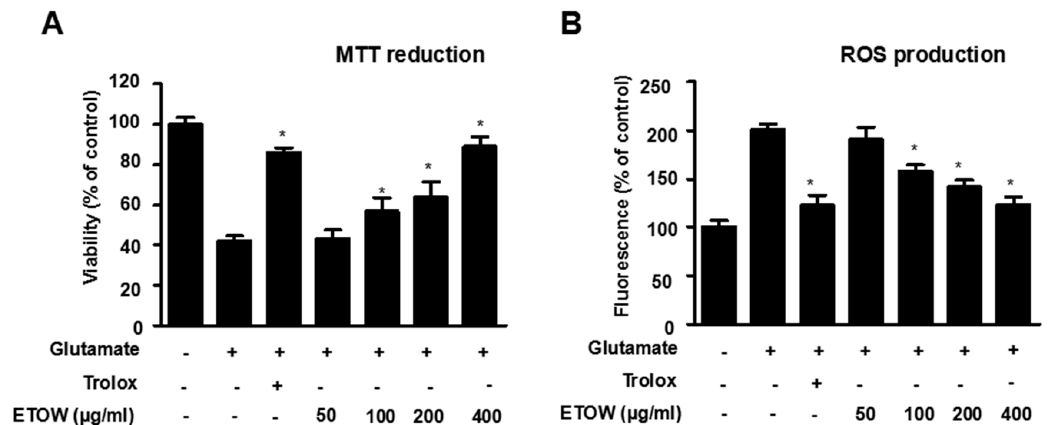
Figure 2. Effects of ETOW on glutamate-induced oxidative neurotoxicity and reactive oxygen species production in glutamate-induced HT22 cells. HT22 cells were pretreated with various concentrations (50, 100, 200, 400 μ g/mL) of ETOW ( A , B ) and then incubated for 12 h with glutamate (5 mM). Trolox (50 μ M) was used as a positive control. Cell viability ( A ) and ROS ( B ) production were measured by MTT assay and DCF fluorescence measurement, respectively. Values are calculated as percentages of untreated cells. Each bar represents the mean ± SD ( n = 3). * p < 0.05 compared to the group treated with 5 mM glutamate. The “+”and “ − ” signs indicates the presence or absence.